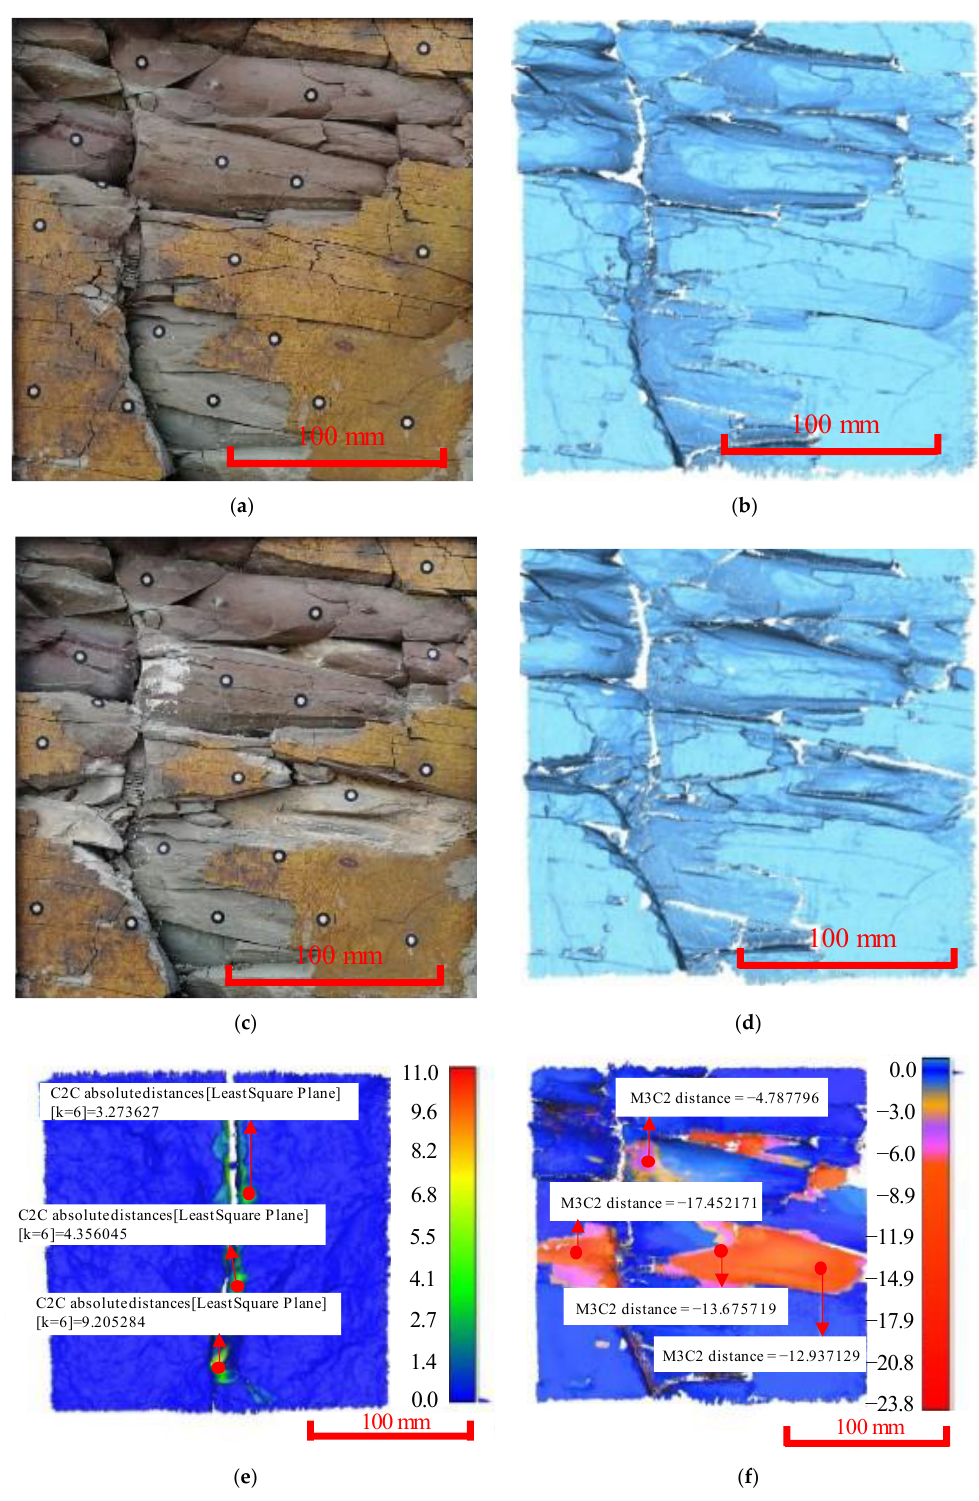
Figure 6. In situ and 3D cloud diagram of the dense joint area. ( a ) Site picture of the measuring area (Period I). ( b ) Image of the 3D laser scanning (Period I). ( c ) Site picture of the measuring area (Period II). ( d ) Image of the 3D laser scanning (Period II). ( e ) Deformation distribution obtained using the C2C method. ( f ) Deformation distribution obtained using the M3C2 method.